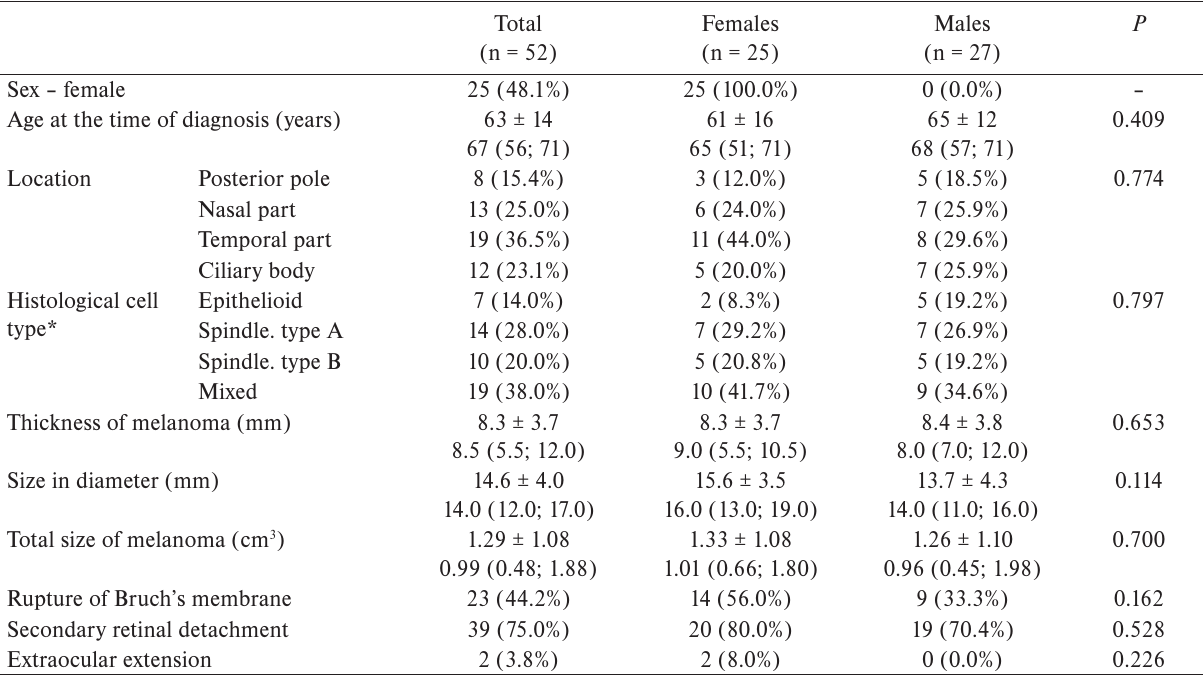
Table 1. Baseline characteristics of patients by